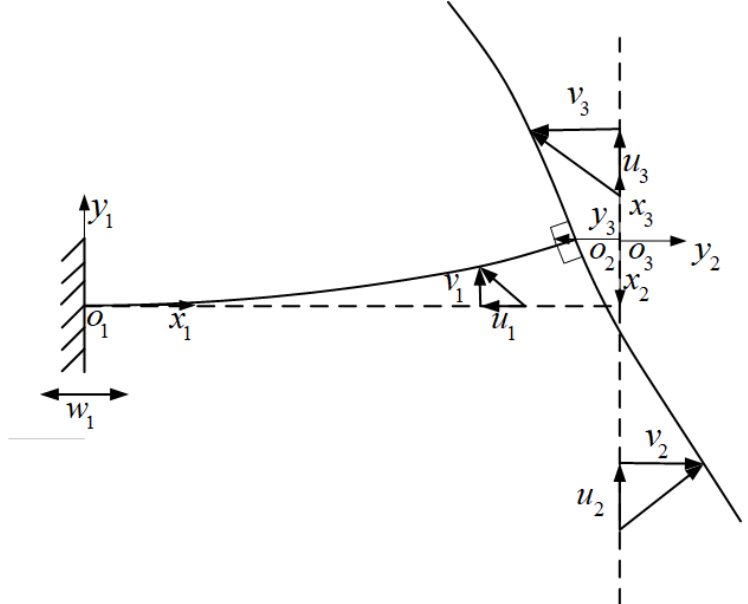
Figure 1. Schematic of T-shaped beam structure. The generalized Hamilton’s principle is expressed as